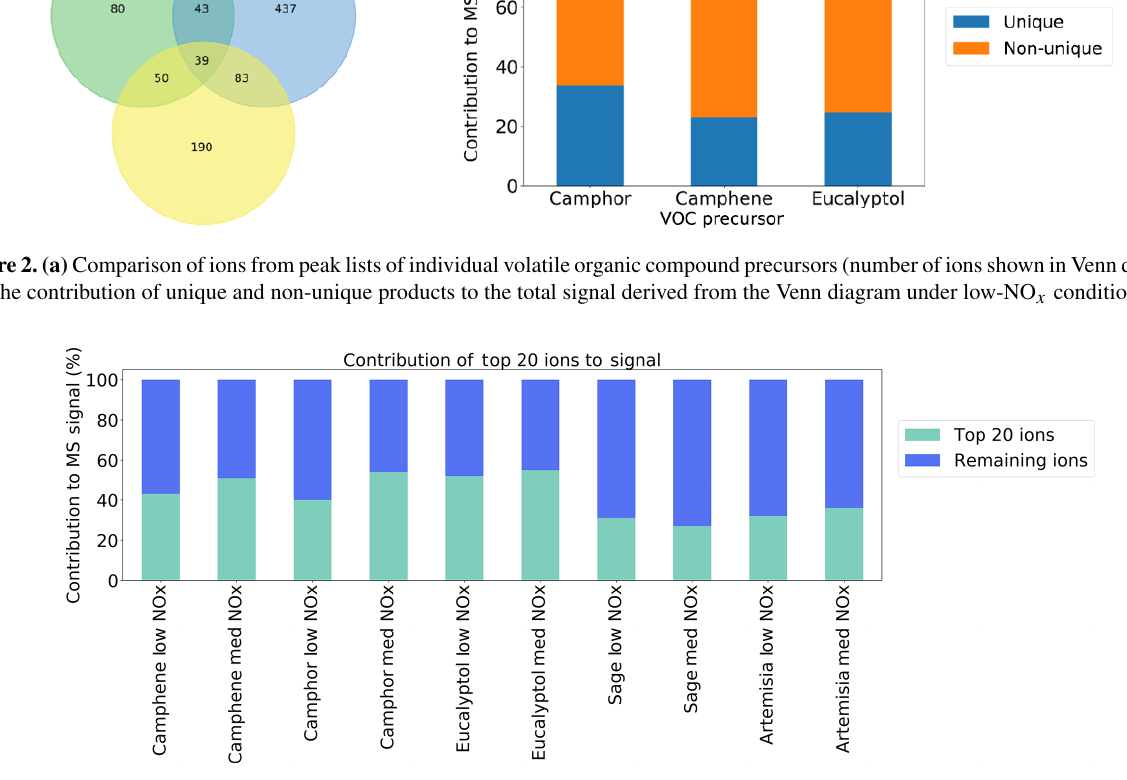
Figure 3. Contribution of the top 20 ions to observed product signal.